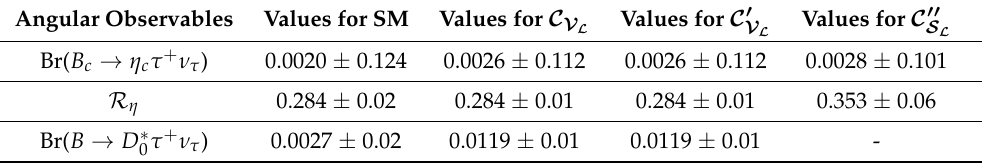
Table 4. Results of branching ratio and angular observables of B c → η c τ + ν τ and B → D ∗ the new complex Wilson